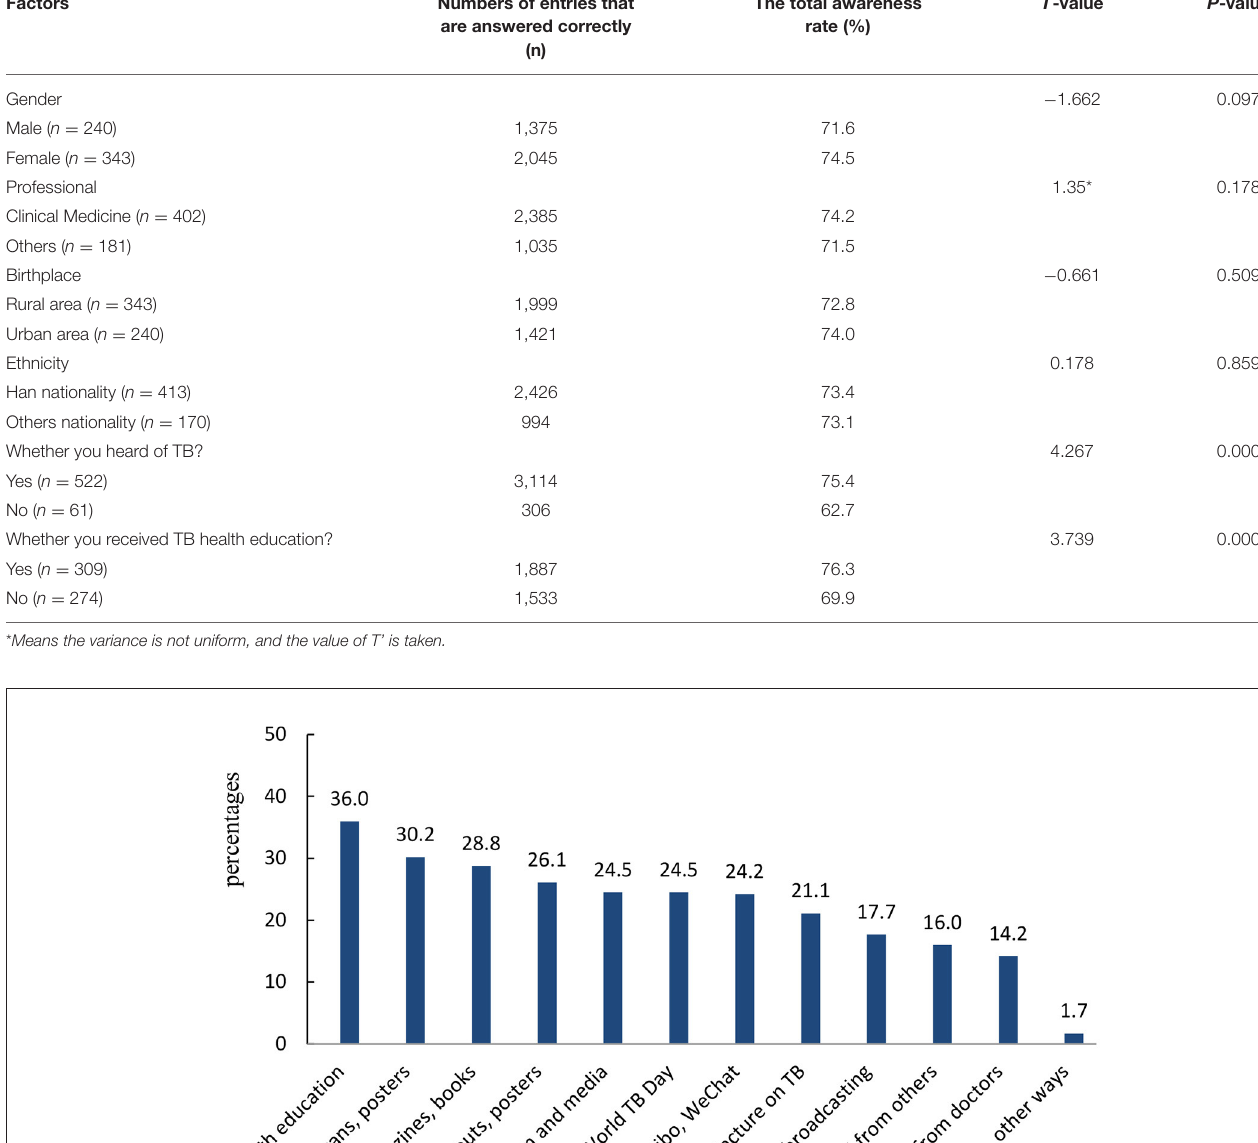
TABLE 4 | The factors associated with the total awareness rate of the eight core knowledge of TB. Factors Numbers of entries that